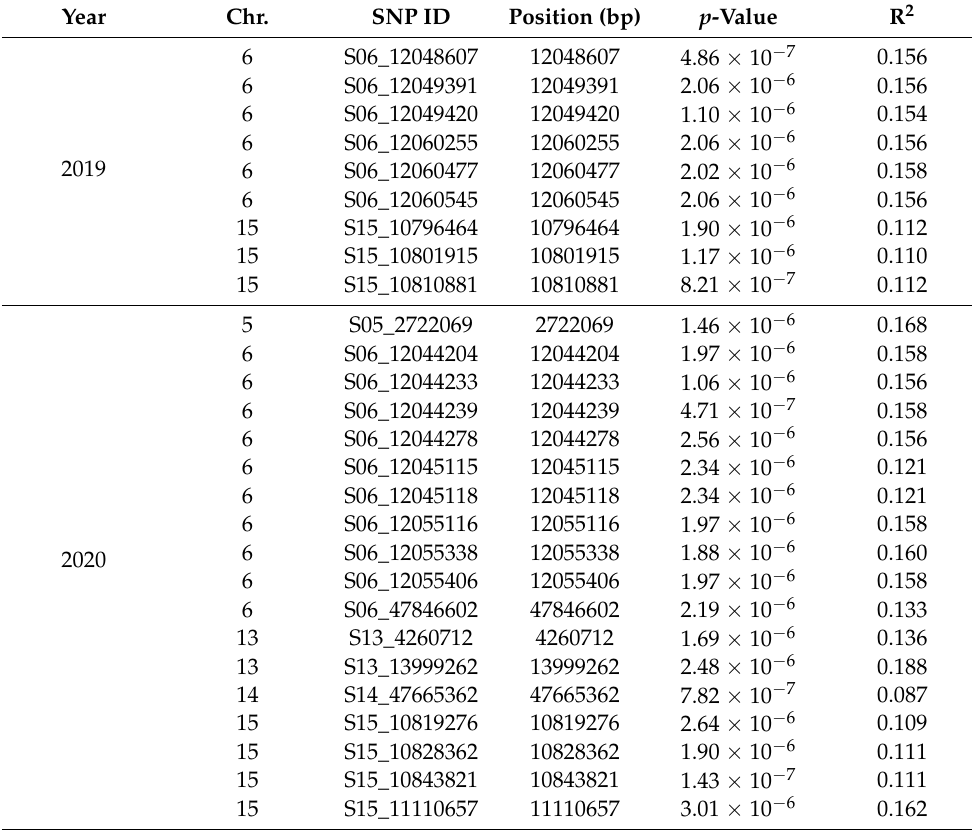
Table 1. SNPs significantly associated with total soluble sugar in two years based on